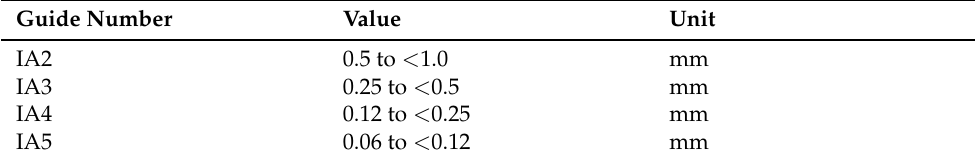
Table 1. Guide numbers of size ranges, according to the EN ISO 945-1 standard. Guide